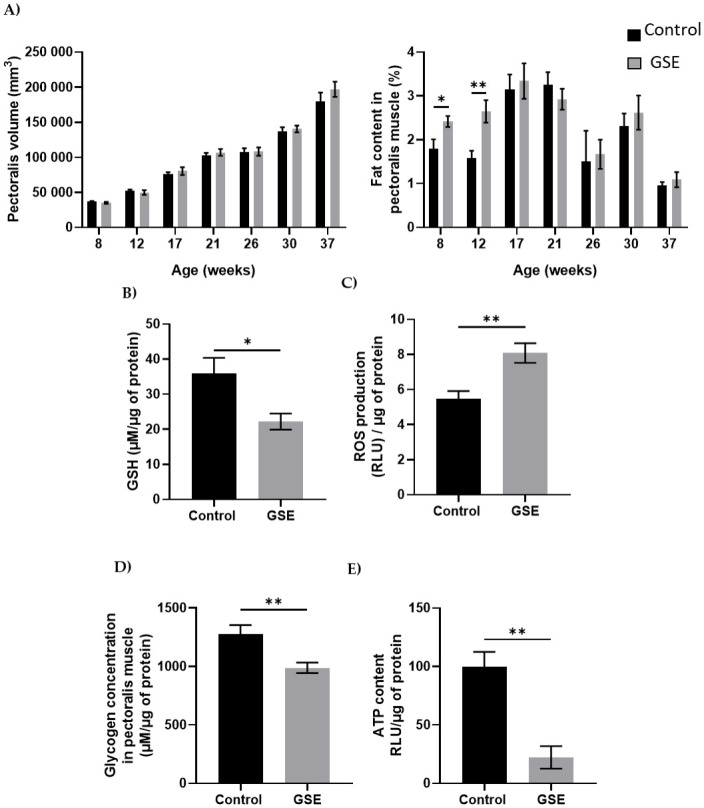
Muscle development.(A) Volume of a section of the right pectoralis muscle (left panel) and percentage muscle fat content (right panel) in male chickens was measured from weeks 8 to 37 (n = 10 animals) was assessed by CT scan every month. (B) Level of Reactive Oxygen Species (ROS, H202, expressed in Relative Luminescent Units/μg of protein) and GSH content (μM/μg of protein) (C) was measured in muscle (n = 5 per group). (D) Glycogen (μM/μg of protein) (E) and ATP content were measured in the pectoralis muscle (n = 5 per group). Results are presented as means ± SEM. *, p < 0.05. **, p < 0.01.